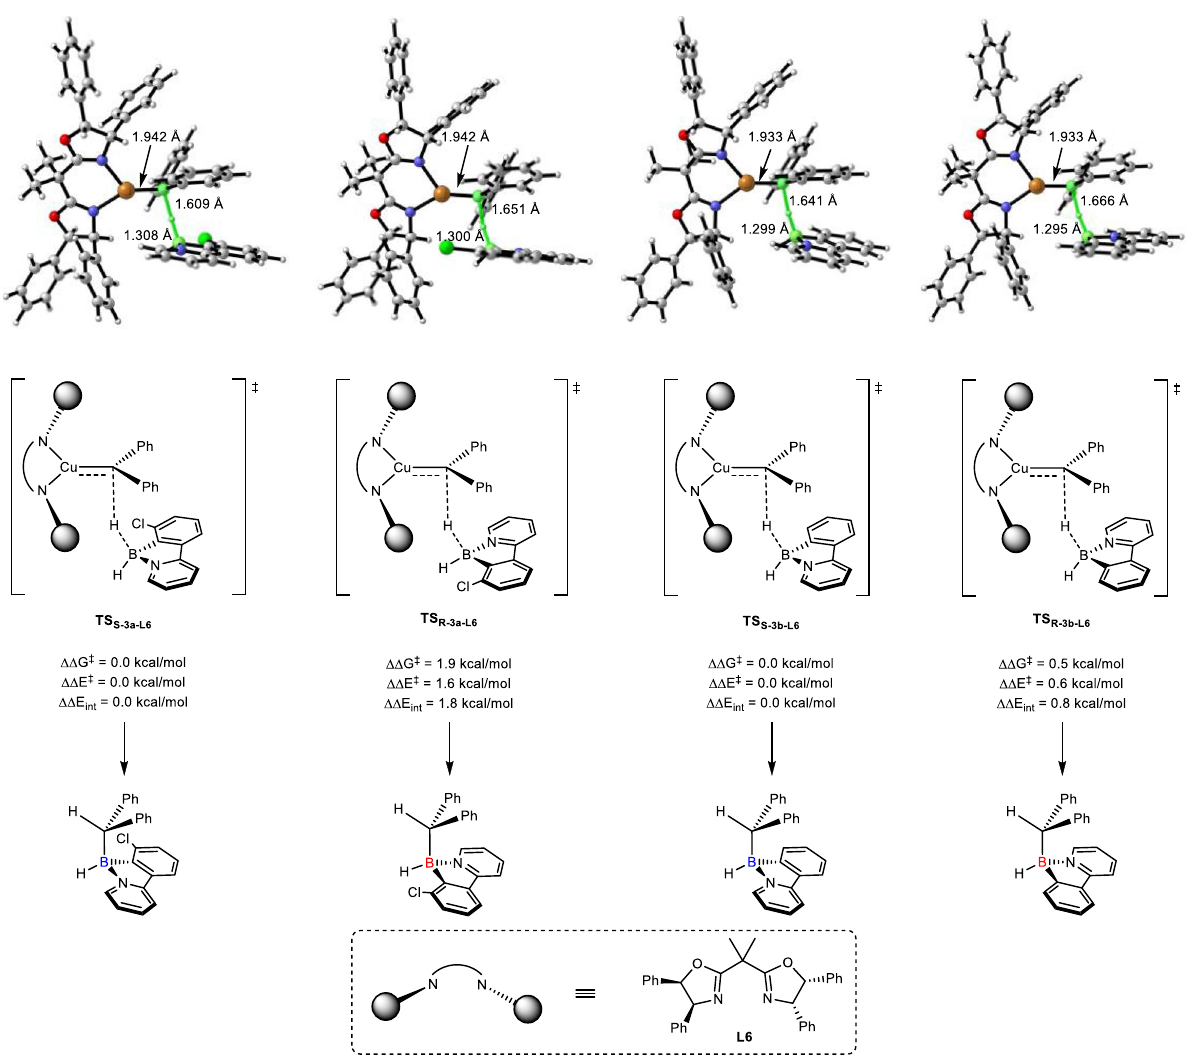
Fig. 3 DFT-calculated key transition state structures for the enantio-determining hydride transfer step with 1a and 1b as substrates. All computational results are performed at the M06/SMD/def2TZVP//B3LYP/SMD/def2SVP level of